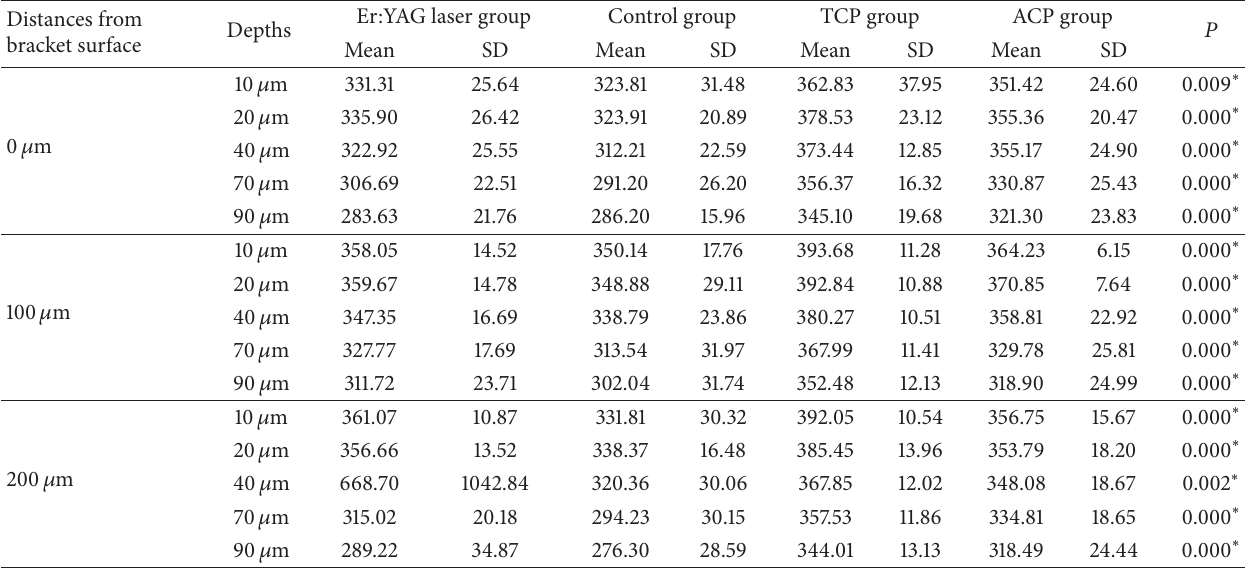
Table 1: Multiple comparisons of microhardness values of specimens from 3 positions and 5 depths from the coronal side of bracket surface. Distances from bracket surface